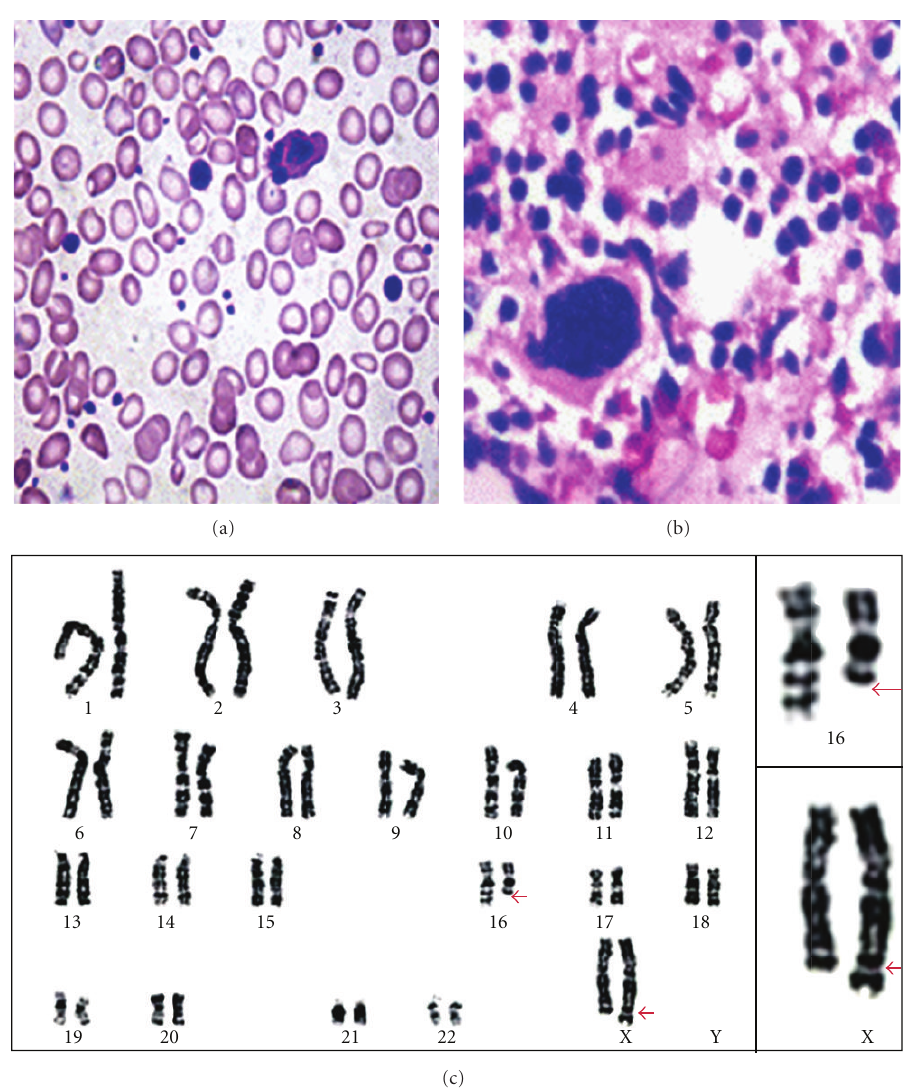
Figure 1: (a) blood smear illustrating tear drop poikilocytes and giant platelets. (b) BM biopsy showing an atypical megakaryocyte. H&E 45x. (c) Karyotypic analysis showing an abnormal clone with 46,X,t(X;16)(q28;q22).